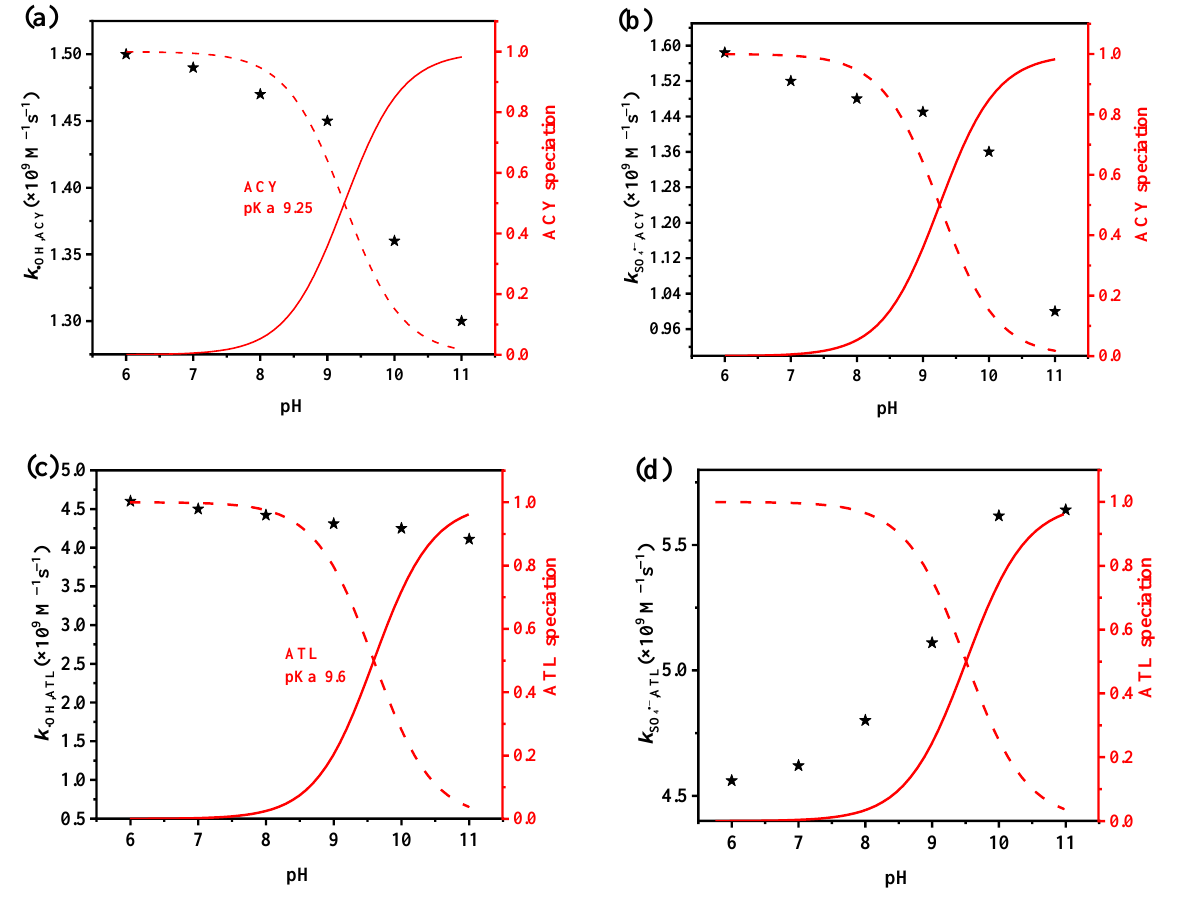
Figure 3. The second-order rate constants of k • OH , ACY ( a ) k ( b ), k • OH , ATL ( c ), and SO •− 4 , ACY k SO •− 4 , ATL ( d ) under different pHs. (black star, measured k ; red lines, speciation). Conditions: [ACY] 0 = 0.022 mM, [ATL] 0 = 0.019 mM, [PDS] 0 = 0.6 mM, pH = 6.0. As shown in Figure 4, with the increase in the solution pH from 6.0 to 11.0, the k obs of ACY and ATL distinctly declined from 0.0931 to 0.071 min −1 and 0.1938 to 0.101 min −1 , k were consistent with the experimental results. Additionally, respectively, and the , ob s m od as the pH increased from 6.0 to 11.0, the k exp , •OH slightly enhanced from 0.00878 to 0.01378 min −1 for ACY degradation and from 0.02607 to 0.04357 min −1 for ATL degradation, re- spectively. However, the overt reduction in • − for ACY and ATL degradation was observed. The •− of ACY and ATL decreased by 30.59% and 63.79%, respectively (Figure 4).